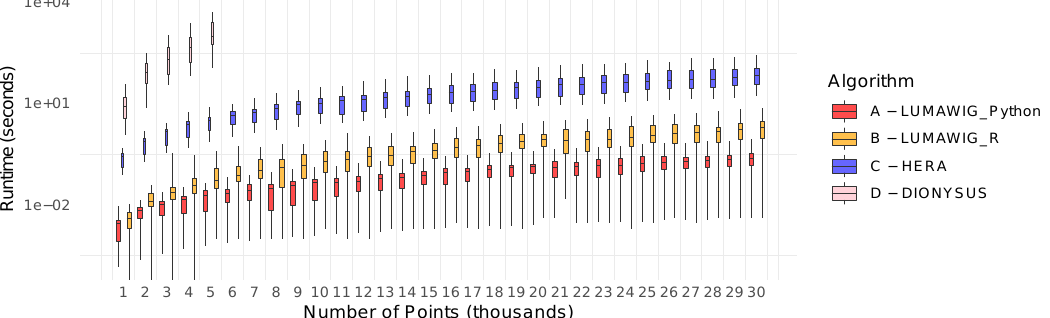
Figure 5. Running time (seconds in log scale) of L UMÁWIG versus the current state-of-the-art implementation in H ERA . Five boxplots for the running time of the original algorithm in D IONYSUS are superimposed for